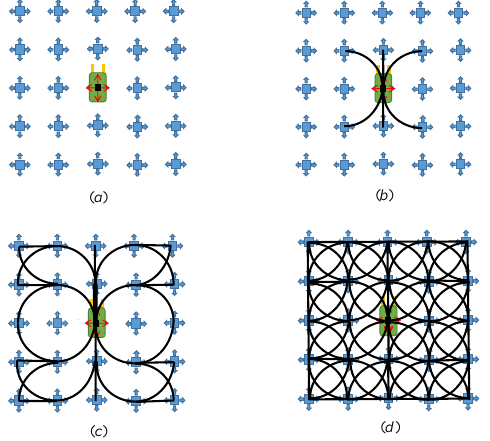
Figure 4. Constructing the lattice for the forklift. ( a ) A discretization in C-space was defined; ( b ) feasible path for 8 neighbor nodes around the origin 8 neighbor nodes around the origin; ( c ) feasible paths extended outward to 24 neighbors, only a few direct paths shown; ( d ) complete